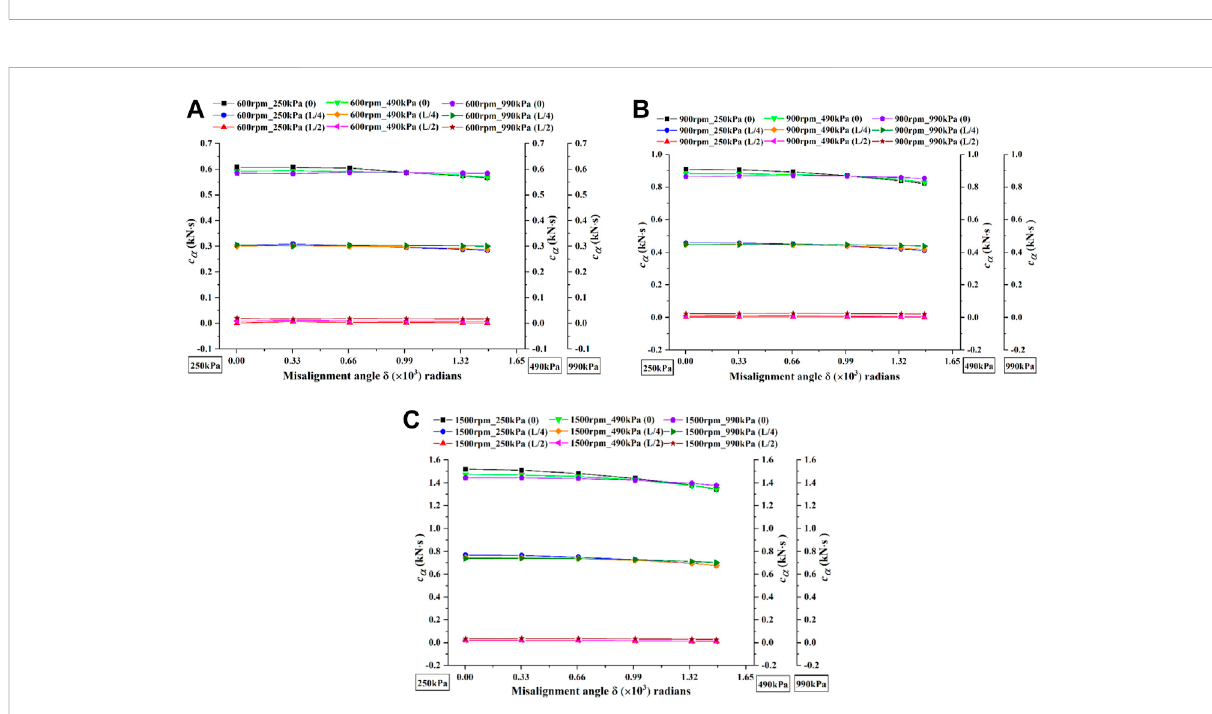
FIGURE 14 The variations of cross-coupled damping coef fi cients with misalignment angle under different pressure differences and rotational speeds. (A) 600rpm. (B) 900rpm. (C)